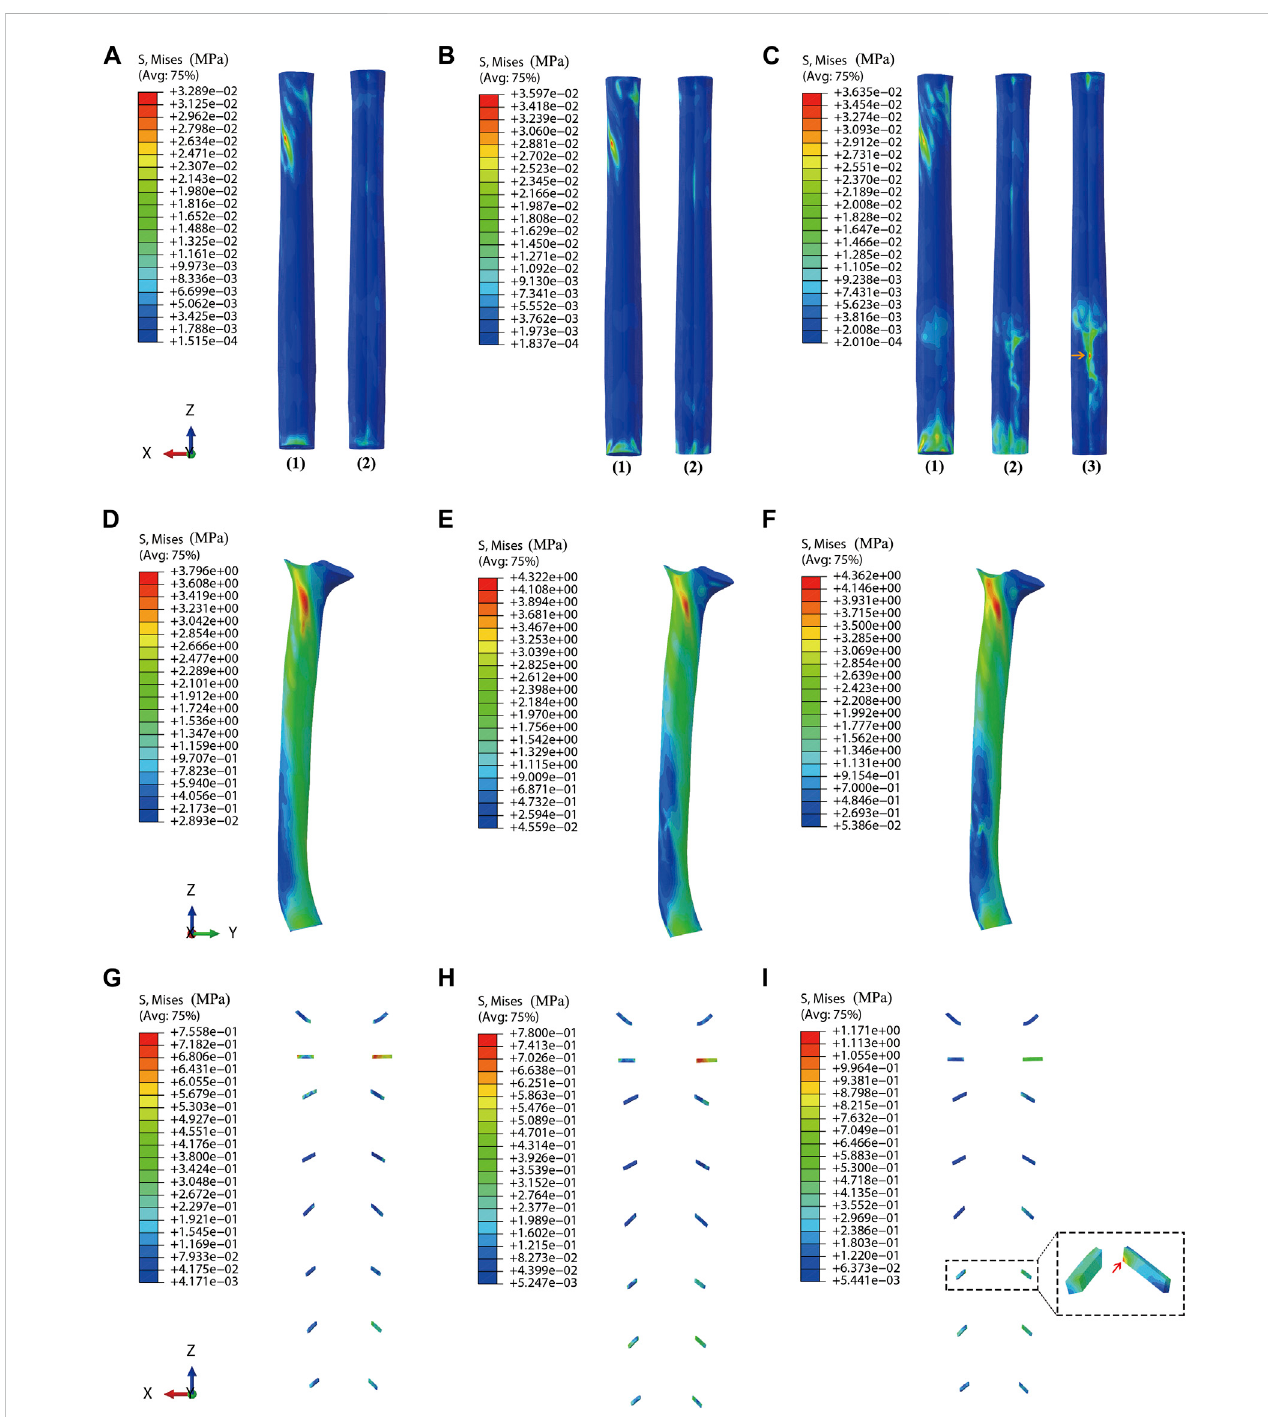
FIGURE 4 Stress distribution on the spinal cord, dura matter, and nerve roots (A) Stress distribution on the spinal cord for the model with mild OPLL. (B) Stress distribution on the spinal cord for the model with moderate OPLL. (C) Stress distribution on the spinal cord for the model with severe OPLL. (1) Dorsal surface ofthespinalcord.(2)Ventralsurfaceofthespinalcord.(3)ThemaximumvonMisesstressattheC5/6segment(compressionleveloftheOPLL)duringthe fi rst half of4 ° z -axis rotation (orange arrow). (D) Stress distributionon theduramatterfor themodel with mildOPLL. (E) Stressdistribution on thedura matter for the model with moderate OPLL. (F) Stress distribution on thedura matter for themodel with severe OPLL. (G) Stress distributionon the nerve roots for the modelwithmildOPLL. (H) StressdistributiononthenerverootsforthemodelwithmoderateOPLL. (I) Stressdistributiononthenerverootsforthemodelwith severe OPLL, and the maximum von Mises stress was at the C6 segment (red arrow). (OPLL, ossi fi cation of the posterior longitudinal